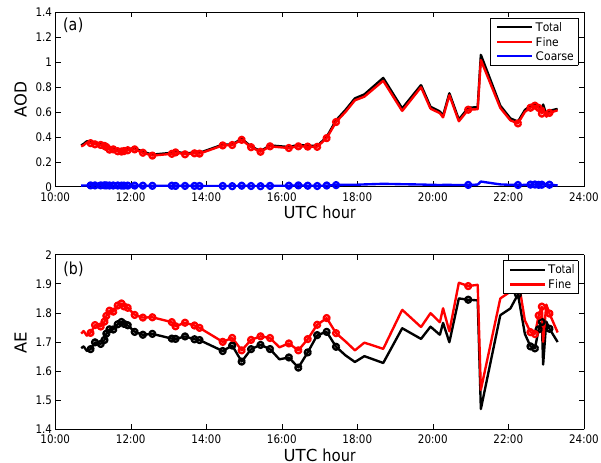
Figure 1. AOD (a) and Ångström exponent (b) in BLDND site near Essex 5 July 2011. Red, blue, and black symbols are for fine mode, coarse mode and total, respectively. level 1 and level 2 measure- ments are indicated by cross and circle,